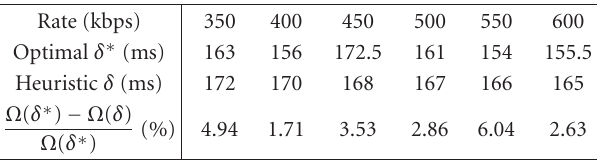
Figure 5: Quality evaluation for scheduling with heuristic and op- timal δ . Table 2: δ ∗ and δ for various average channel rates.